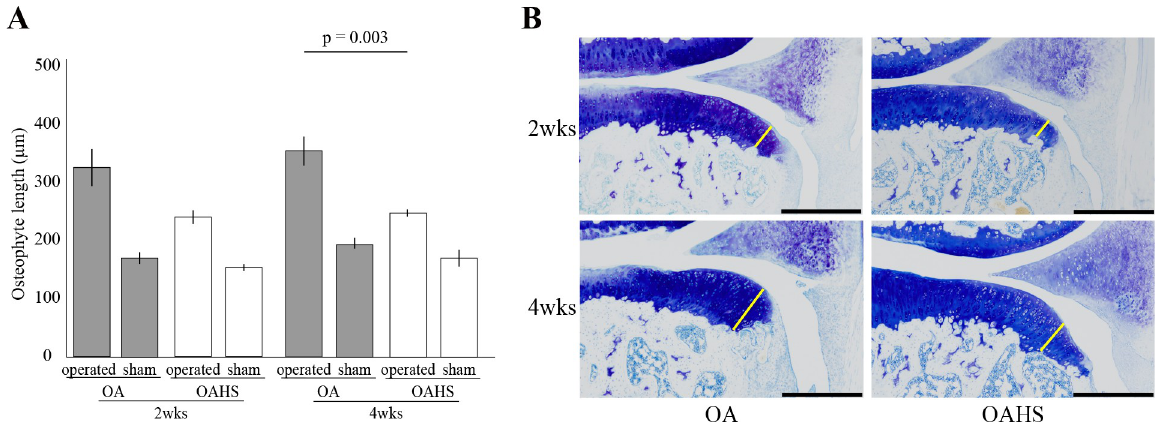
Fig 5. Results of histological and histomorphological changes in osteophyte formation. As the graph (A) and histological images (B) show, no significant difference in the operated limb was found between both groups at 2 weeks, but osteophyte length was longer in the OA group than that in the OAHS group at 4 weeks. Scale bar = 500 μ m.